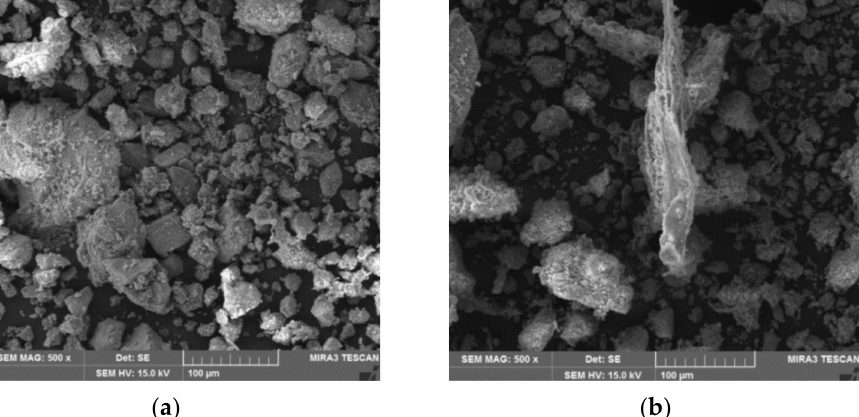
Figure 6. Alternative components (by-products) for modification of cement-bonded particleboard composition—pictures from TecScan MIRA3 XMU scanning electron microscope: ( a ) PM—particle mixture from cement-bonded particleboard production; ( b ) DU—dust from cutting of cement-bonded particleboards during their